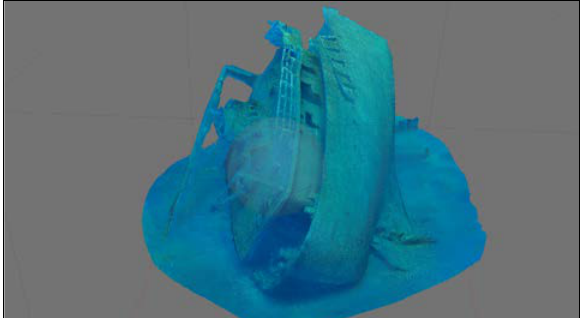
Figure 5. Digital textured model